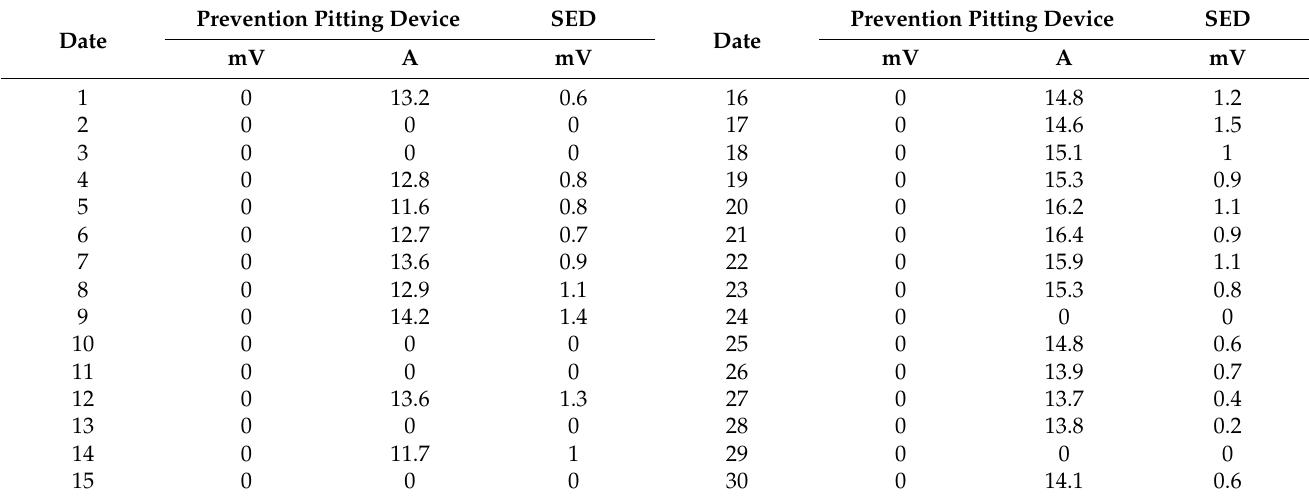
Table 4. The performance test log sheet of the device in a real vessel.